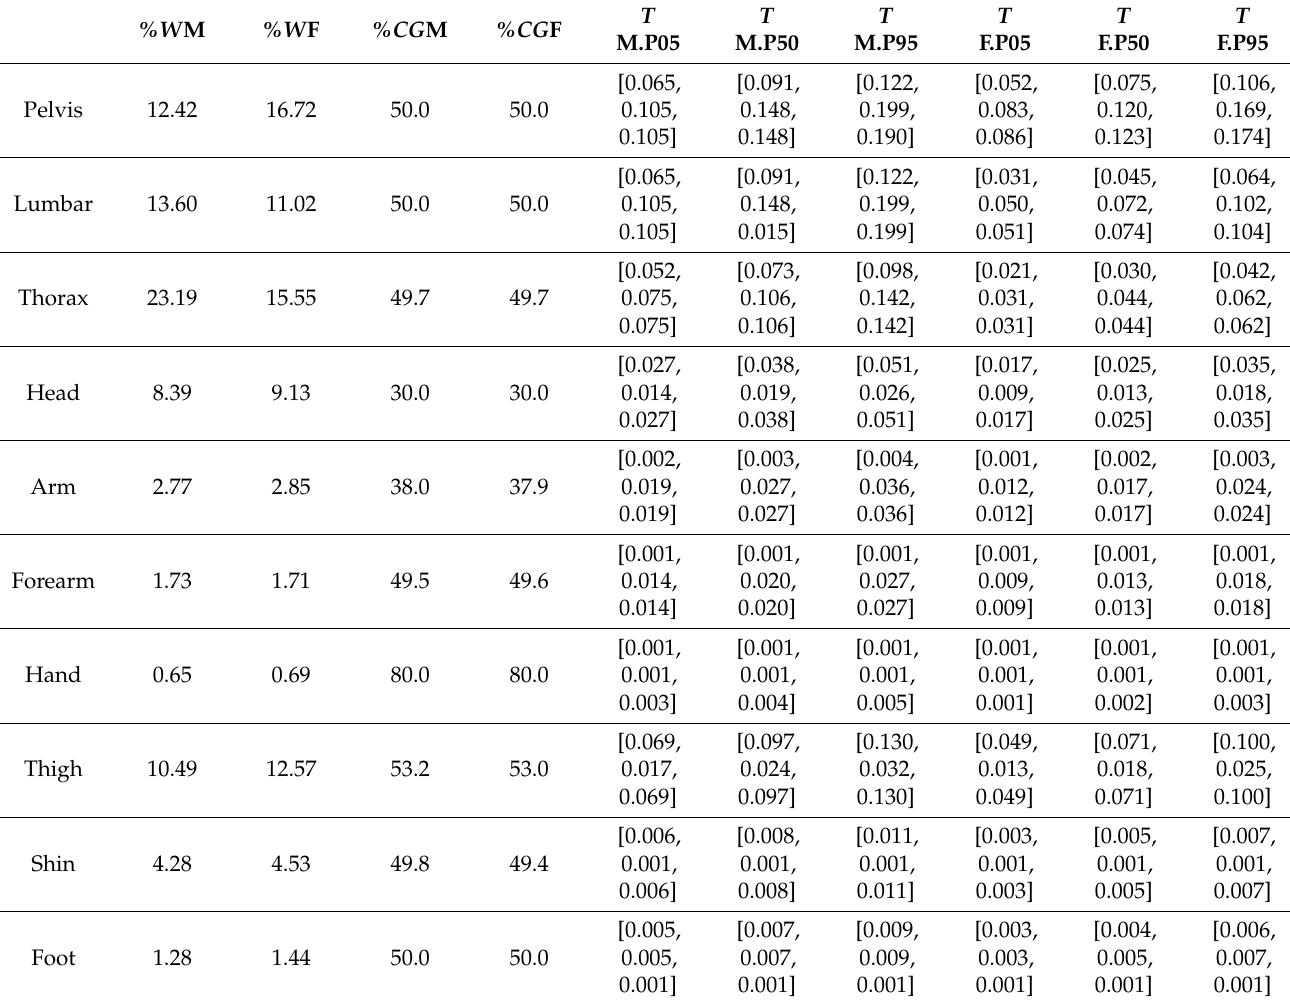
Table 2. Values of % W , % CG , and T for the kinetic calculation according to Huston